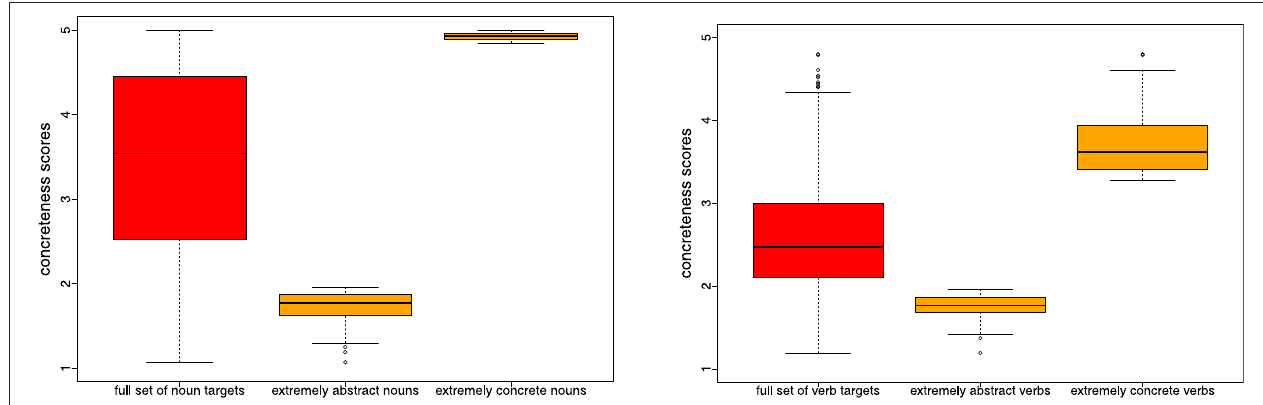
FIGURE 1 | Distributions of concreteness scores on a 5-point rating scale from 1 (abstract) to 5 (concrete) for our full concreteness sets of 5,448/1,280 nouns/verbs and for the 500/200 most extreme abstract and concrete